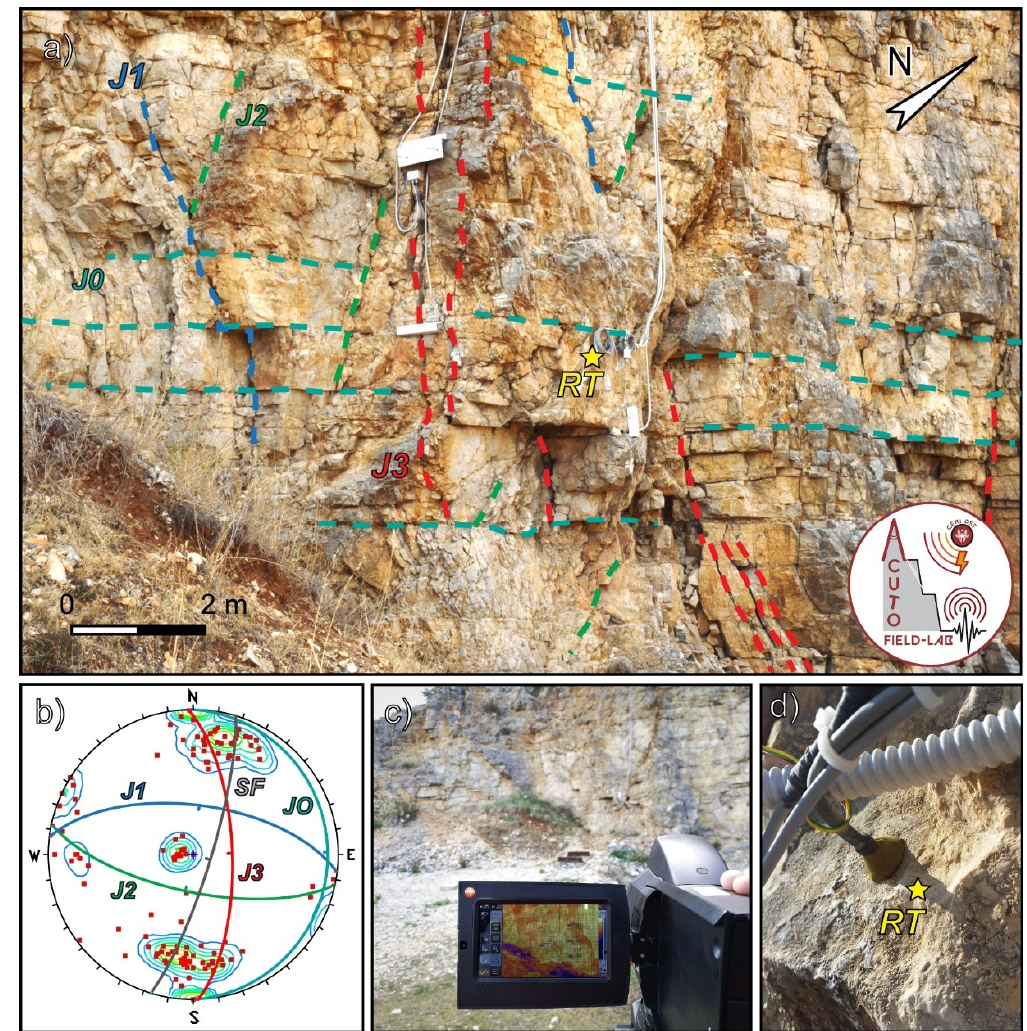
Figure 2. ( a ) Monitored sector of the Acuto quarry wall along with traces of the main joints dissecting the rock mass and ( b ) synthetic representation of joint sets in the Schmidt stereonet. ( c ) Indirect (i.e., IRT) and ( d ) direct (i.e., thermocouple) thermal surveys were performed to evaluate distributed temperature fields over the rock mass surface.